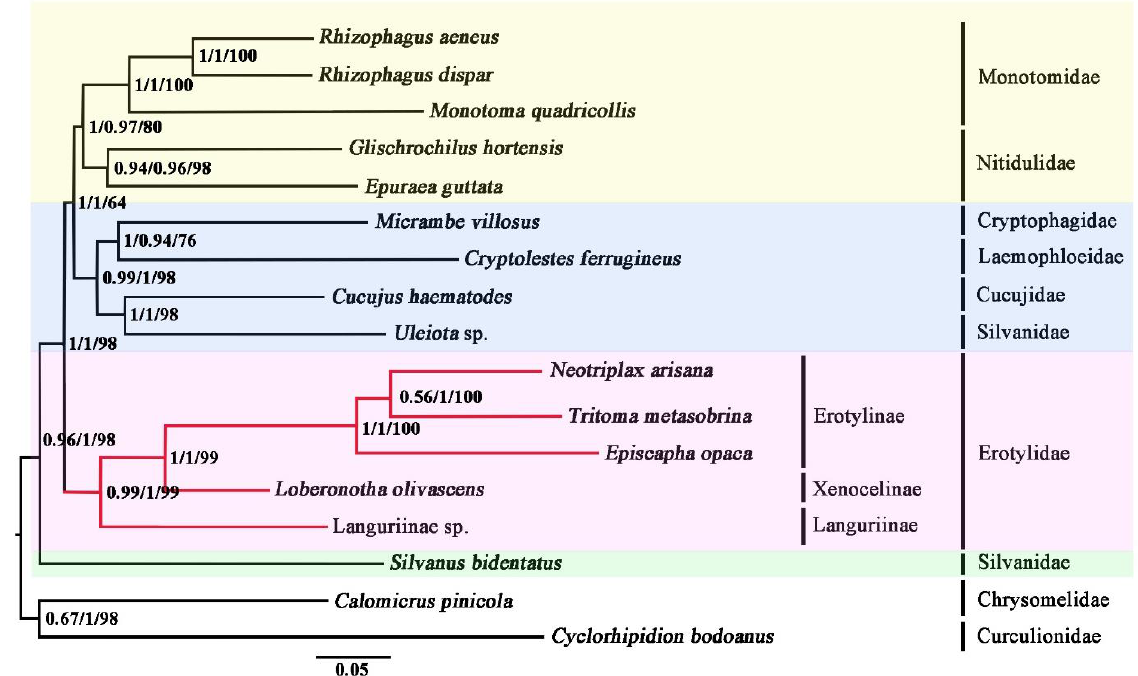
Figure 5. Phylogenetic relationships among Cucujoidea. Shown here is the phylogeny inferred from the AA dataset using PhyloBayes with the CAT-Poisson model. Analyses of the PCG123R dataset using both IQ-Tree with the GTR + F + I + G4 model and PhyloBayes with the CAT-GTR model obtained the same topology as shown here. The first values at each node represent the posterior probabilities from PhyloBayes analysis of the AA dataset with the CAT-Poisson, the second represents the posterior probabilities from PhyloBayes analysis of the PCG123R dataset with the CAT-GTR model, and the third values represent bootstrap supports from IQ-Tree analysis of the PCG123R dataset with the GTR + F + I + G4 model.